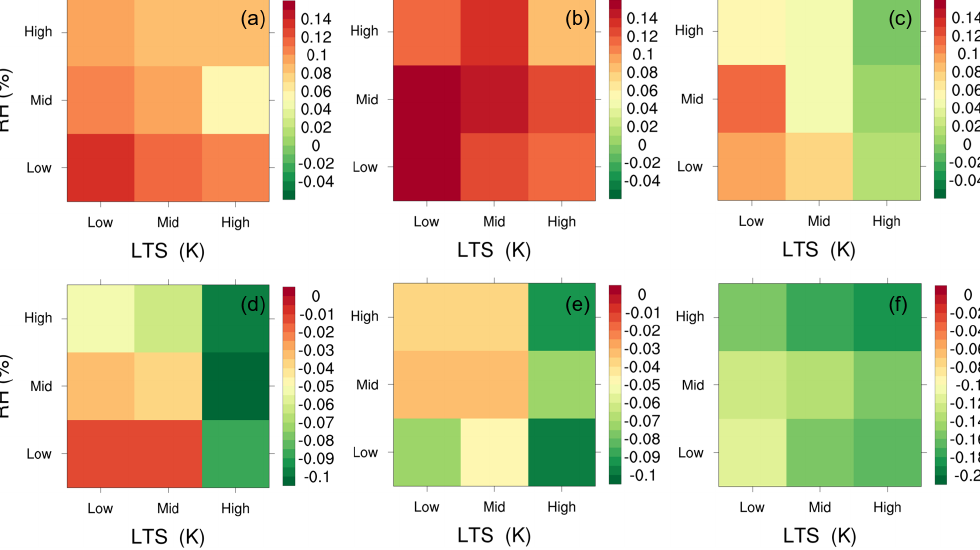
Figure 9. The slopes of CER versus AOD (AI) on a log–log scale under low, medium, and high LTS and RH CT conditions, respectively, over (a) EC, (b) EU, (c) WE, (d) ECO, (e) EUO, and (f)